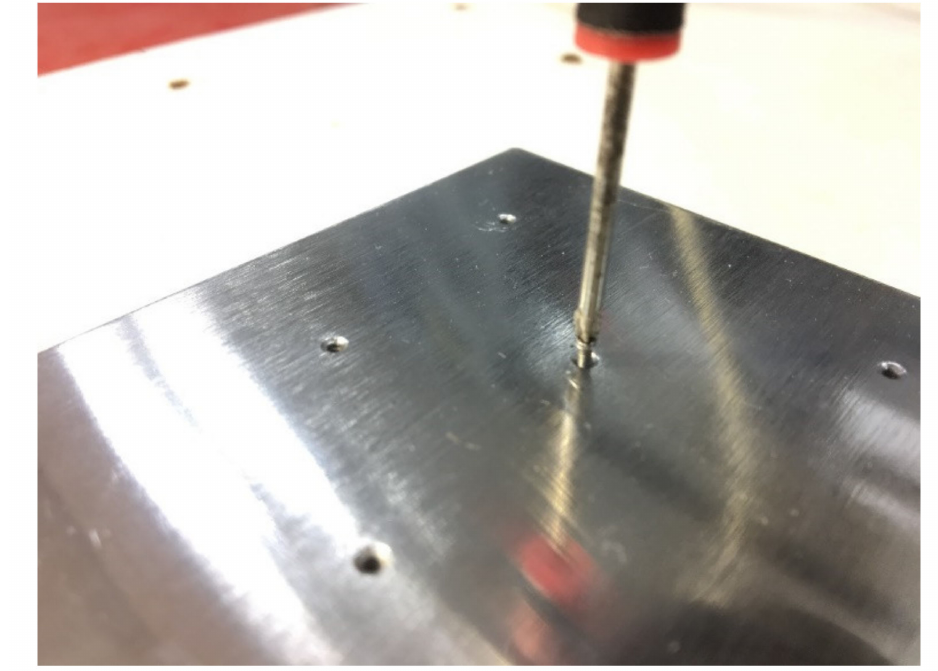
Figure 11. A screw comes into contact with the workpiece and tightening